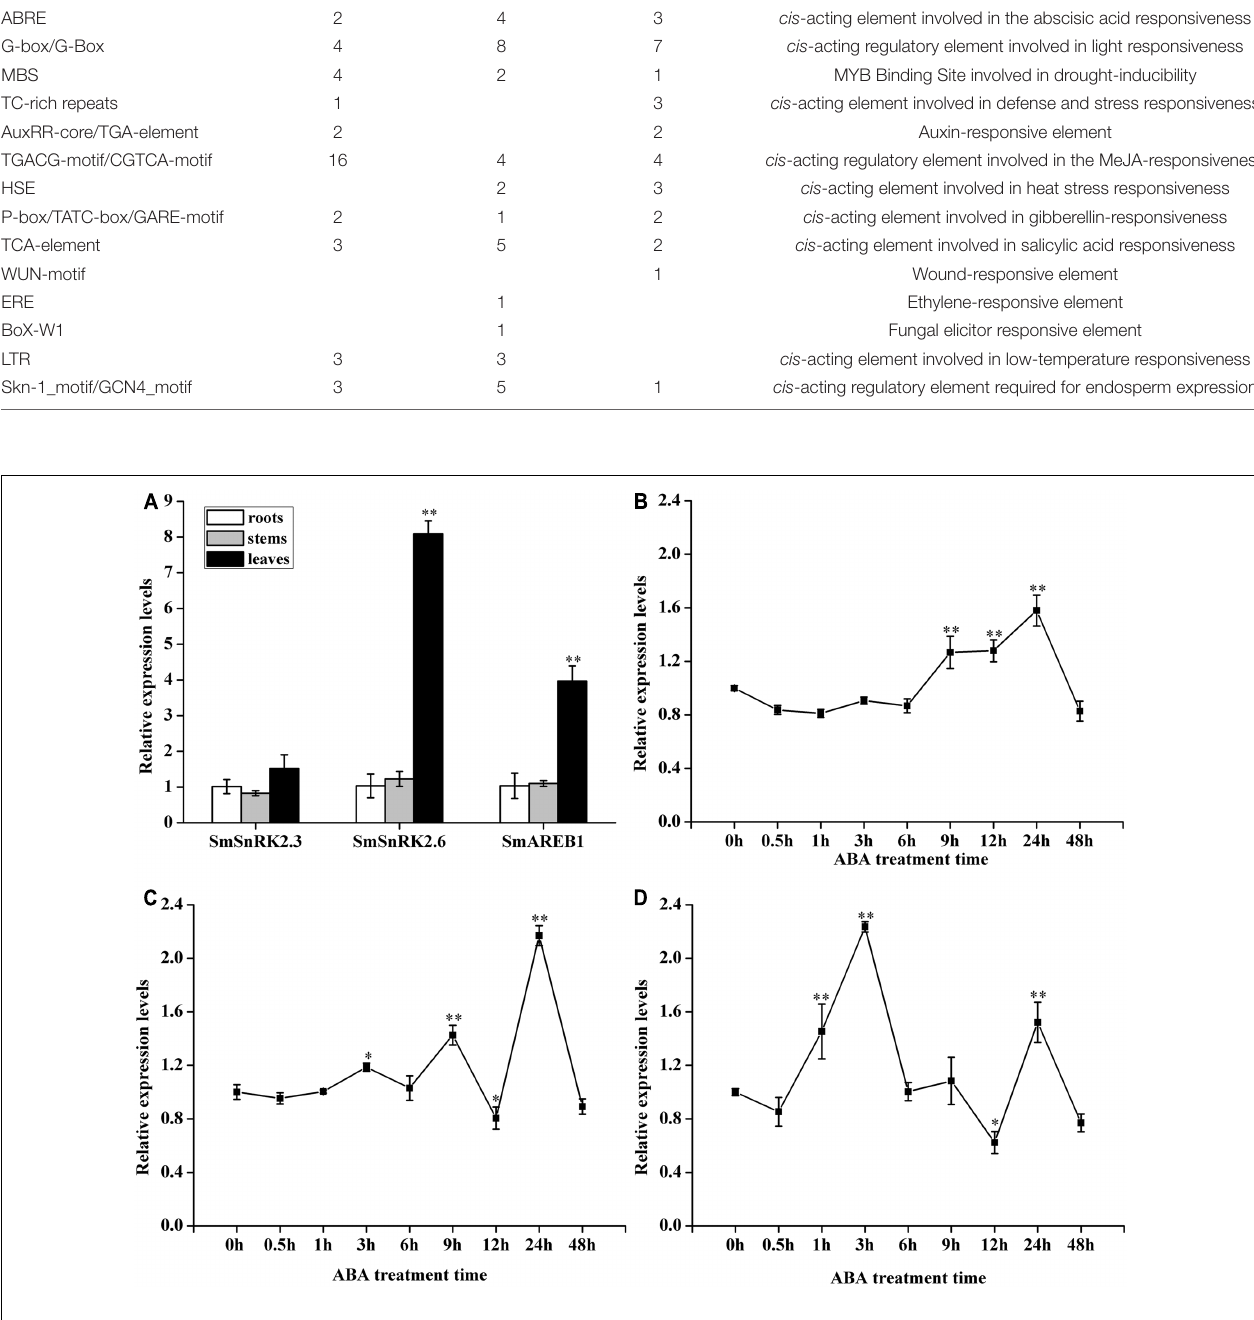
FIGURE 3 | Expression patterns of SmSnRK2.3 , SmSnRK2.6 , and SmAREB1 in various tissues and in response to exogenous ABA treatment. (A) Expression patterns of SmSnRK2.3 , SmSnRK2.6 , and SmAREB1 in different tissues of S. miltiorrhiza. The expression levels in roots were arbitrarily set to 1 as control. (B–D) Expression patterns of SmSnRK2.3 , SmSnRK2.6 , and SmAREB1 under exogenous ABA treatment. The expression levels at 0 h were arbitrarily set to 1 as control. Data represent means ± SD of three replicates. Asterisks denote significant differences compared to control samples at ∗ P < 0.05, ∗∗ P < 0.01, according to Tukey’s